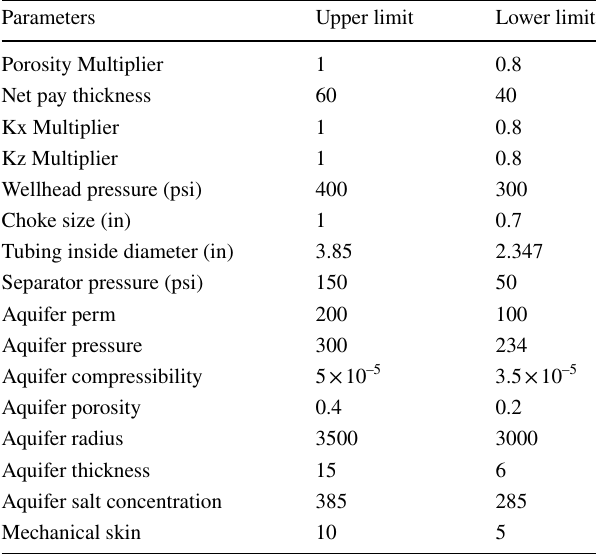
Table 7 Sixteen selected parameters of the integrated production sys- tem with upper and lower levels for each sensitivity test